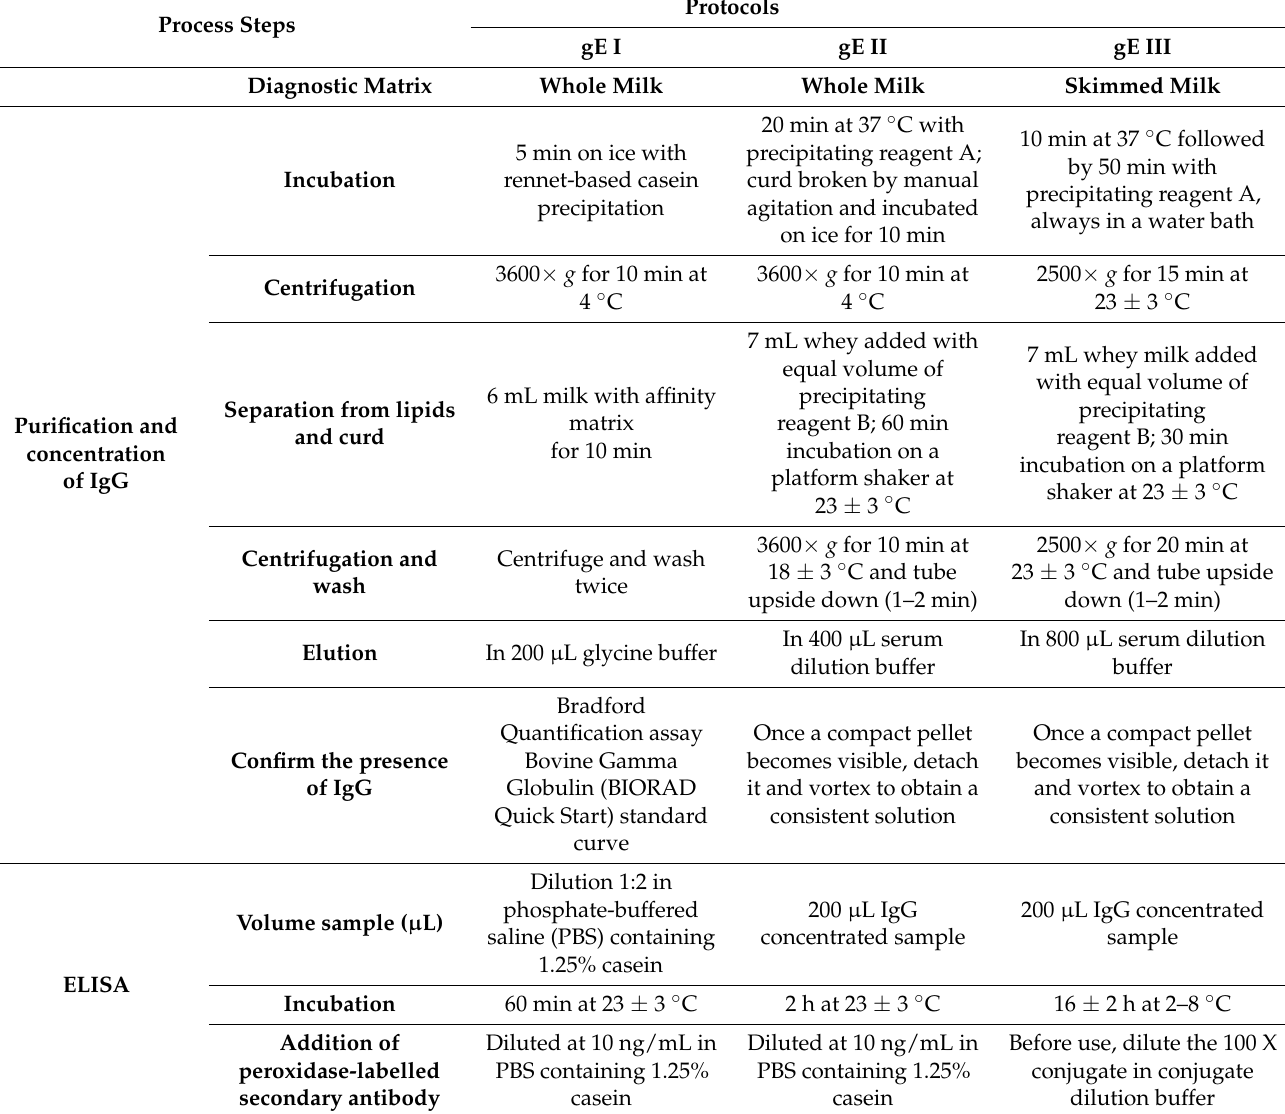
Table 1. Main differences between the protocols used in the gE indirect ELISA described by Muratore et al. (2017) (gE I) [33], reported by Colitti et al. (2018) (gE II) [22], and used in this study (gE